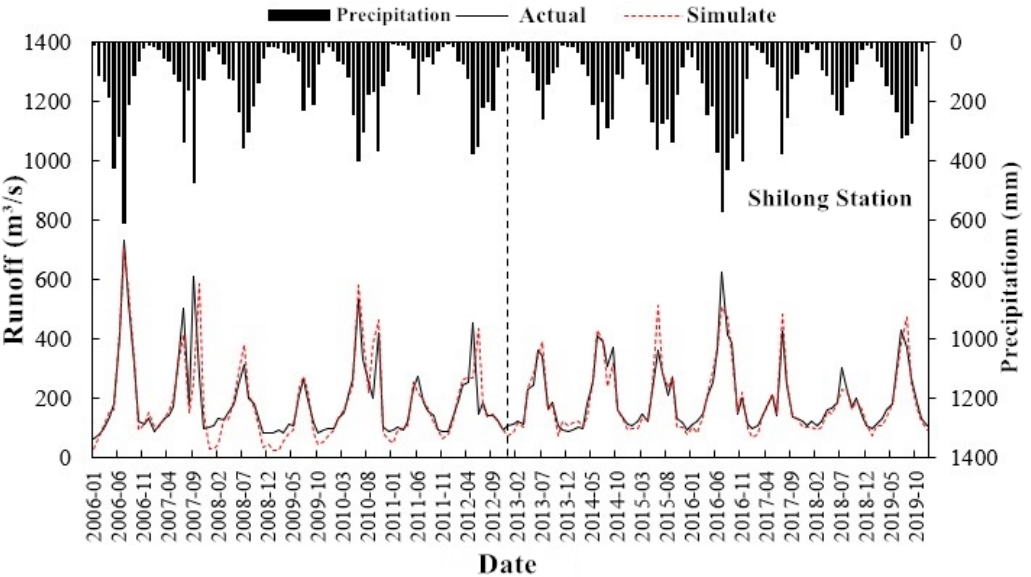
Figure 6. Comparison of measured and simulated runoff data for the Shilong hydrological station in the Jinjiang watershed.